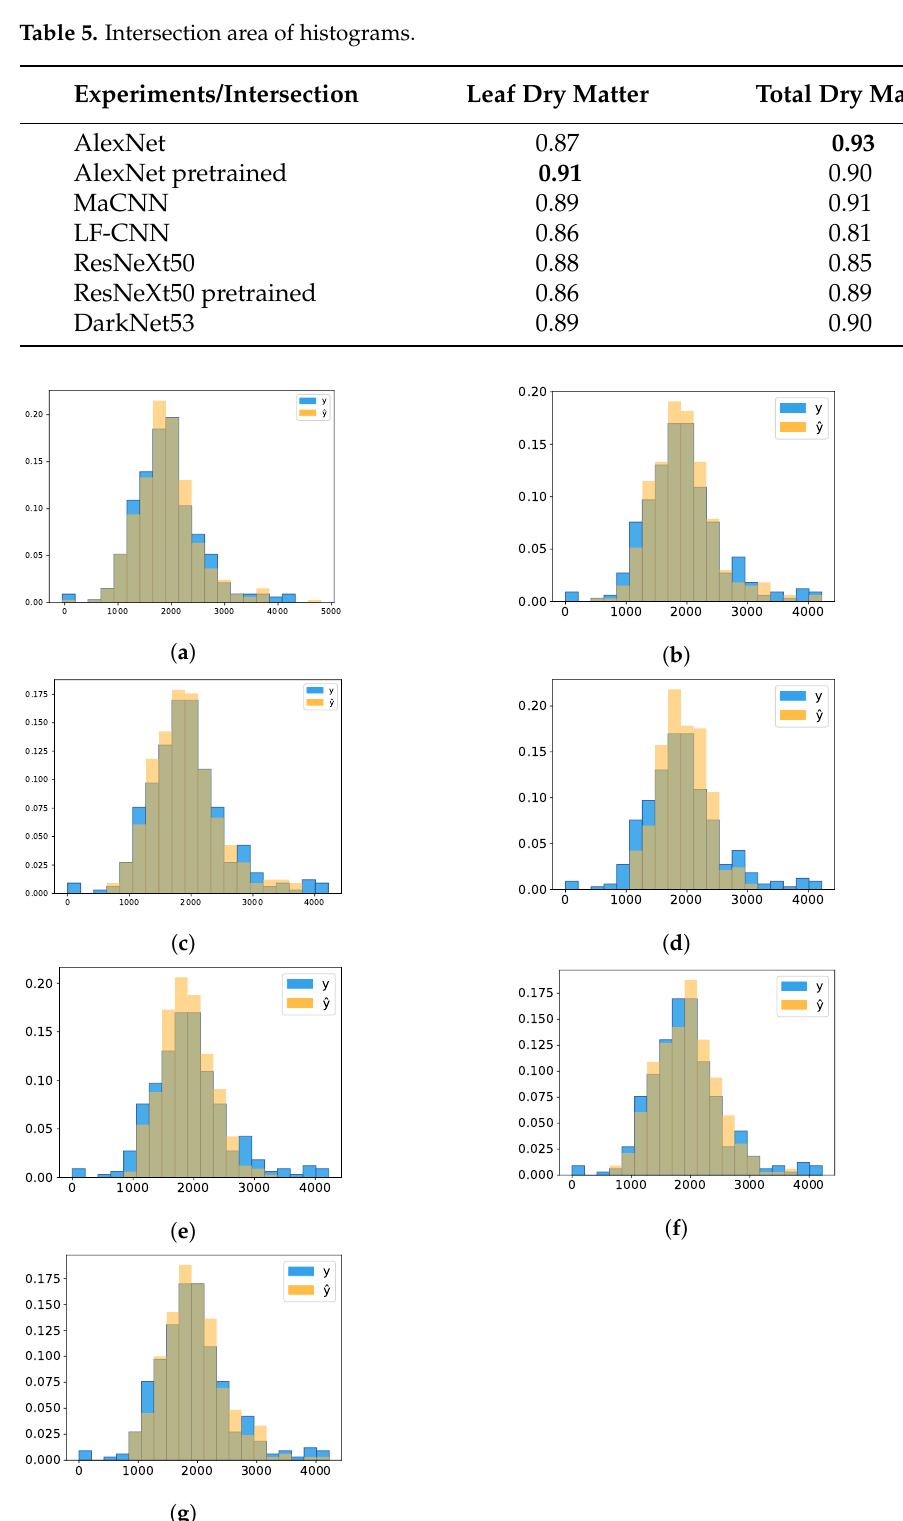
Figure 7. Comparison of predicted ˆ y vs. real y in relation to TDMY data distribution. ( a ) AlexNet; ( b ) AlexNet pretrained; ( c ) MaCNN; ( d ) LF-CNN; ( e ) ResNeXt50; ( f ) ResNeXt50 pretrained; ( g )